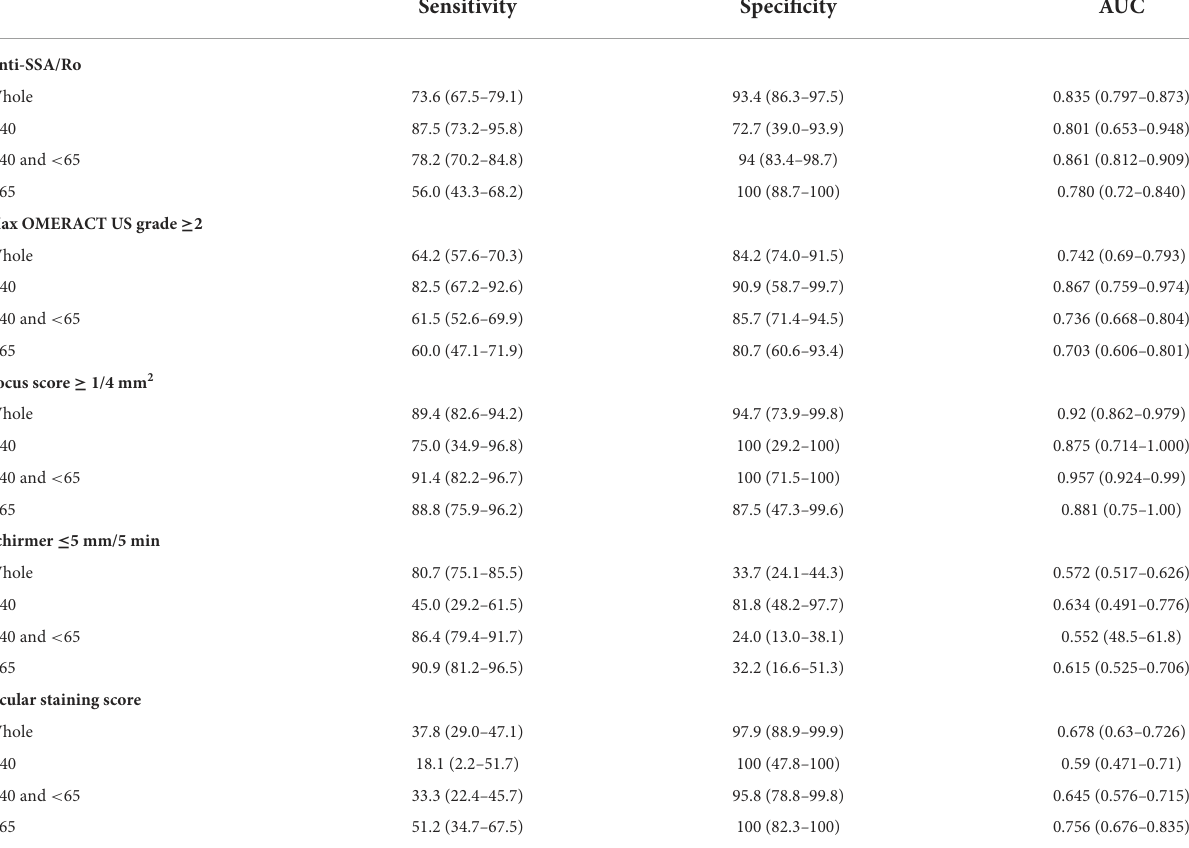
TABLE 3 Diagnostic performance of items in the ACR/EULAR criteria of primary Sjögren’s syndrome and salivary gland ultrasound according to the age group. Sensitivity Specificity